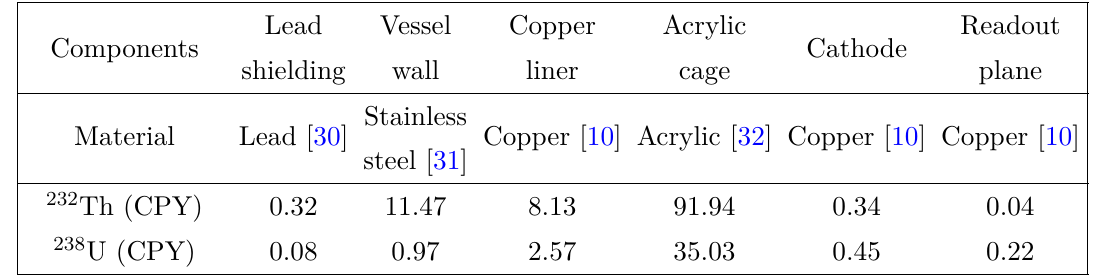
Table 2. Within ROI, the background rates from the 232 Th and 238 U decay chains in different geometry parts for the configuration of (3 mm strip, 3%). The majority of the background are from the acrylic field cage, the copper liner, and the stainless vessel.